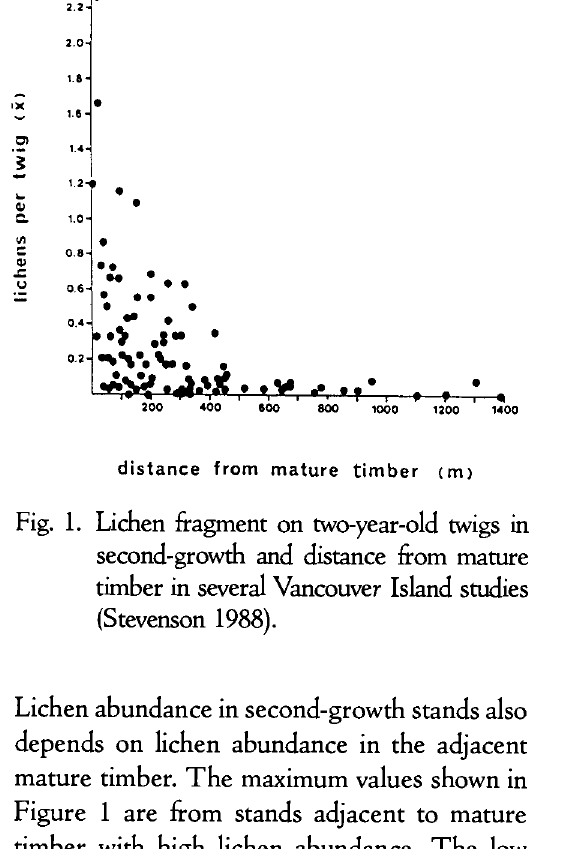
Fig. 1. Lichen fragment on two-year-old twigs in second-growth and distance from mature timber in several Vancouver Island studies (Stevenson